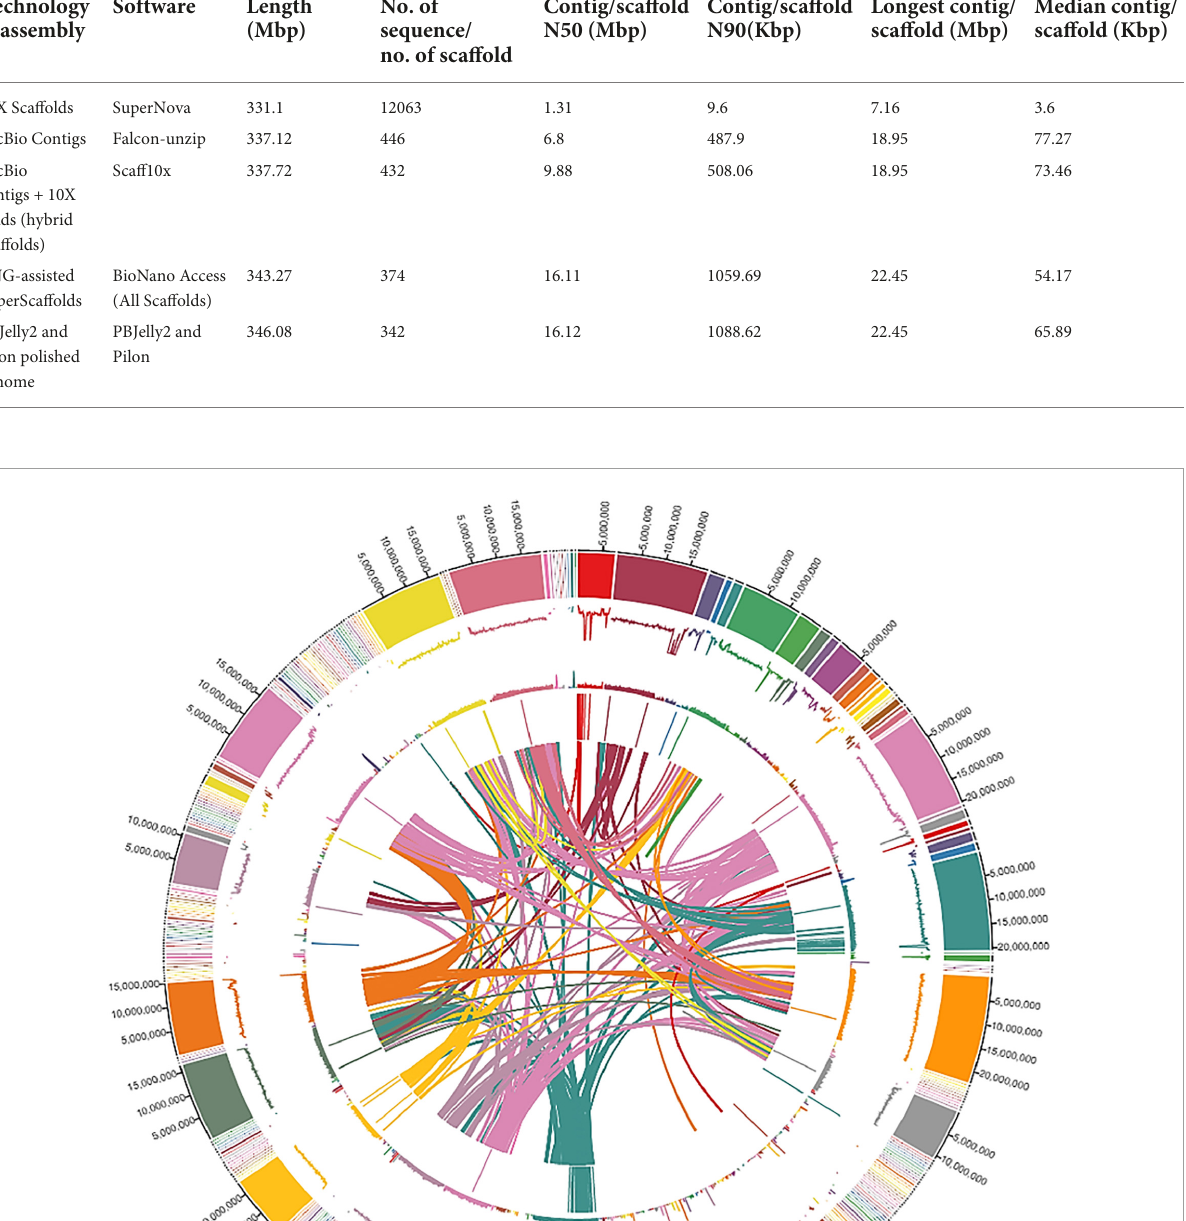
TABLE 2 Statistics at each step of the pomegranate genome assembly.